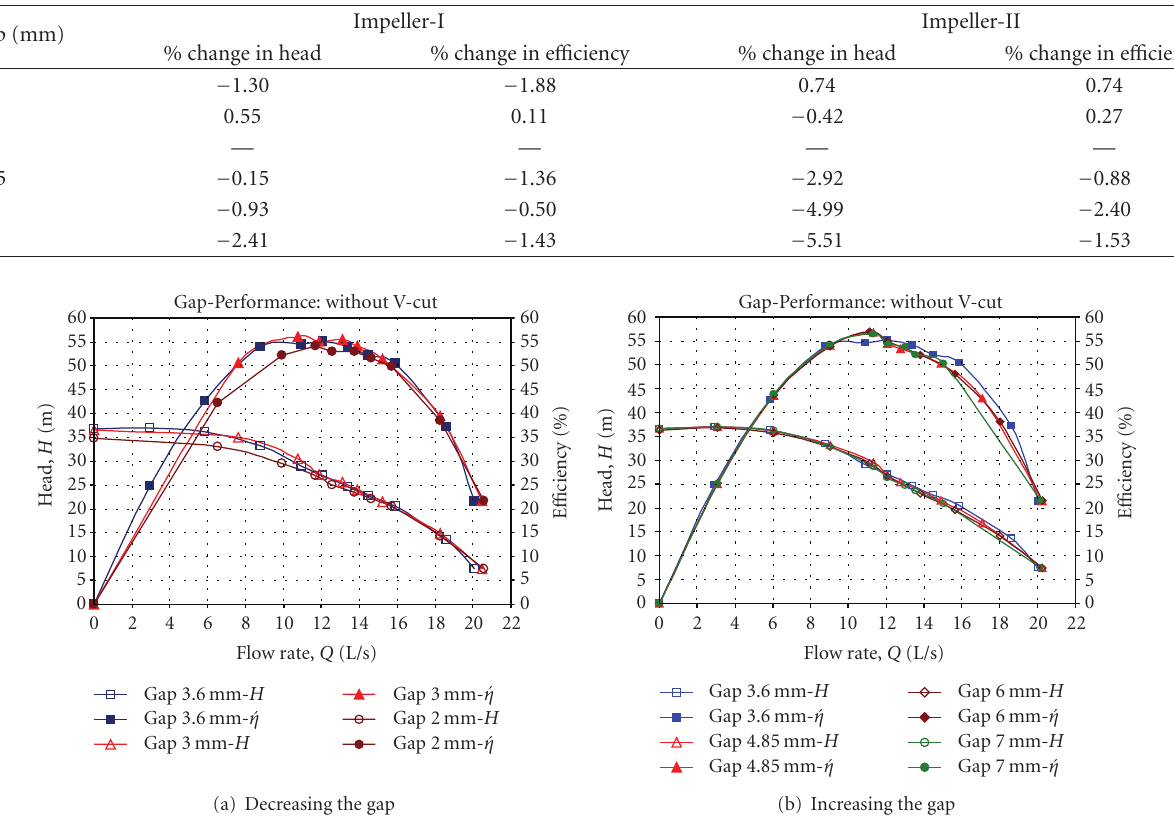
Table 3: E ff ect of gap on pump performance, Q = Q n .